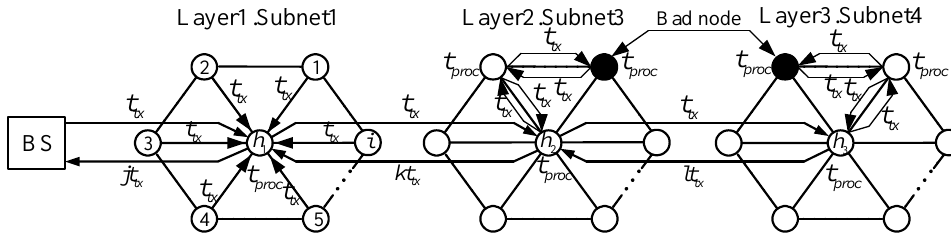
Figure 9. Process of transmission delay with bad